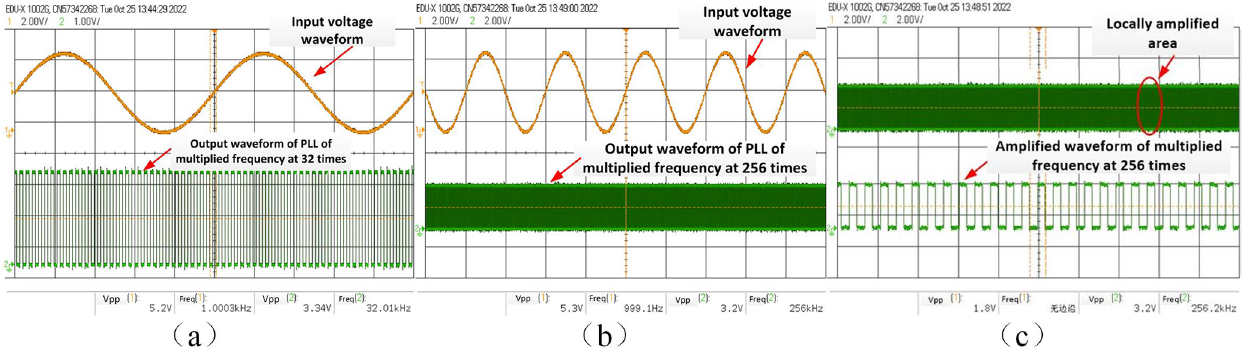
Figure 7. The output waveform of a phase-locked loop of multiplied frequency at (a) 32 and (b) 256 times and (c) amplified waveform of multiplied frequency at 256 times. (© Keysight Technology EDUX1002G Digital Storage